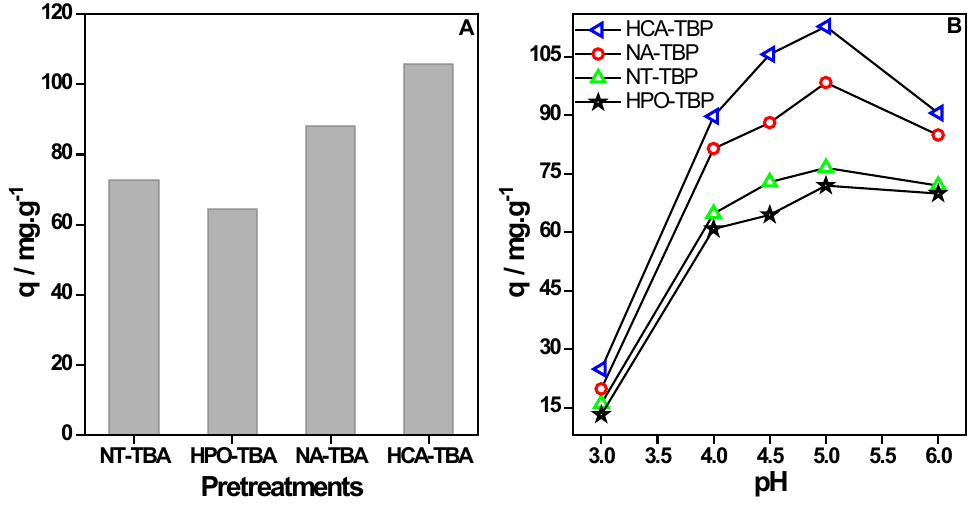
Figure 1: Effect of pretreatment (A) and pH (B) on Pb(II) removal by original and chemically pretreated